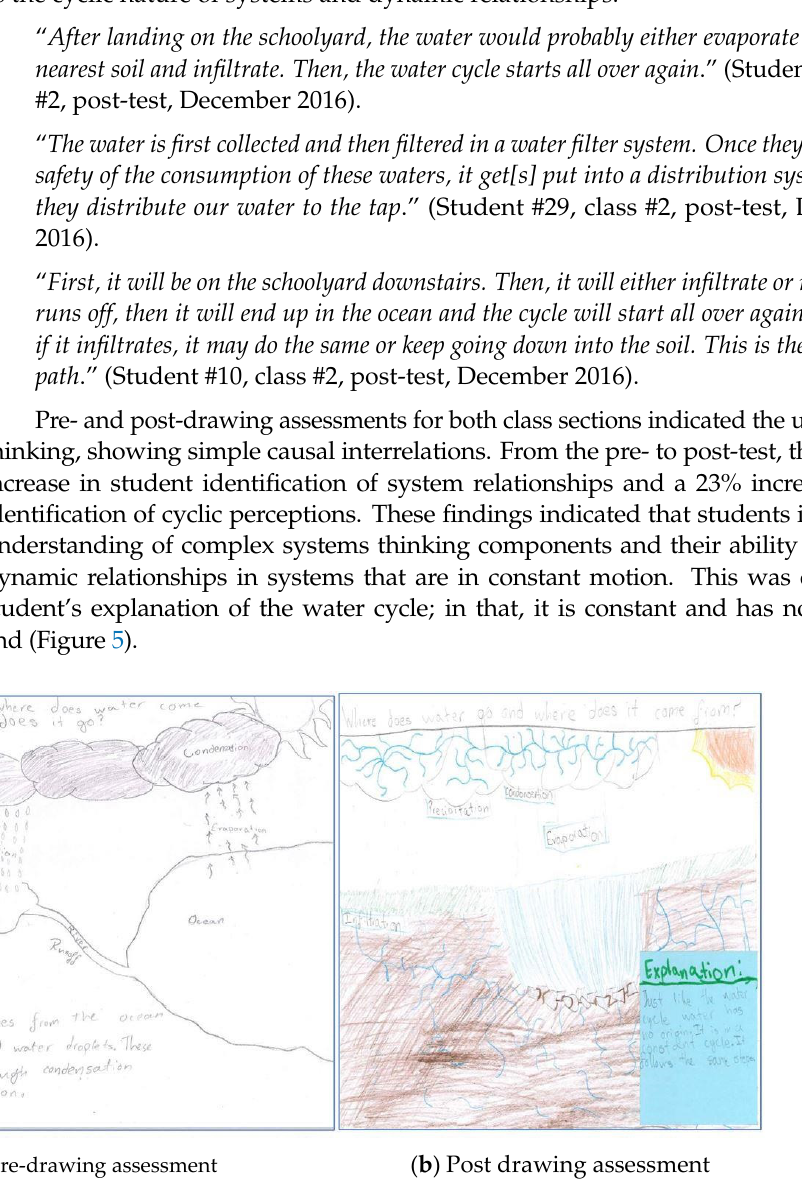
Figure 5. Pre and Post Drawing Assessments from - Student 36, Class #1 that show the progression from simple structural thinking ( a ) to cyclic thinking ( b ). Explanation on post drawing assessment ( b ) states: “Just like the water cycle, water has no origin. It is in a constant cycle. It follows the same steps.